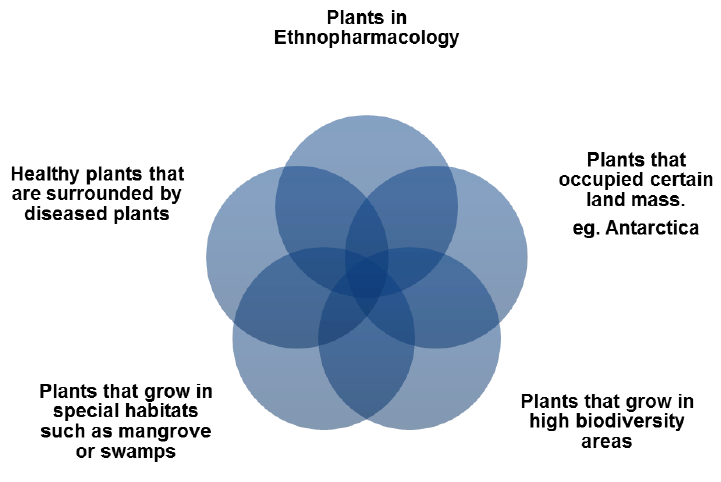
Figure 3: The Rationale Behind Choosing The Plants for Endophytic Research. Intensity of the shaded area on the diagram indicate the higher possible of endophytes with greater bioactive